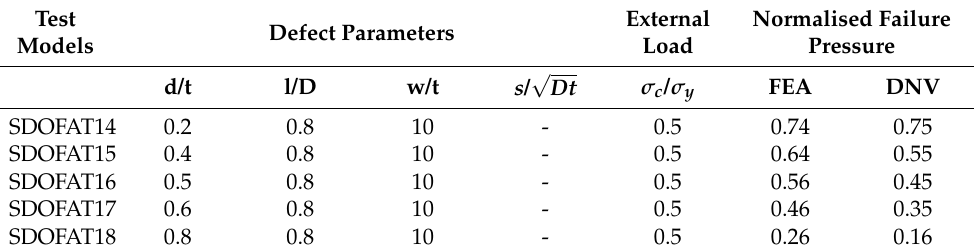
Table 4. FEA on a corroded pipeline with single and longitudinally interacting corrosion defects subjected to internal pressure and longitudinal compressive stress with various defect